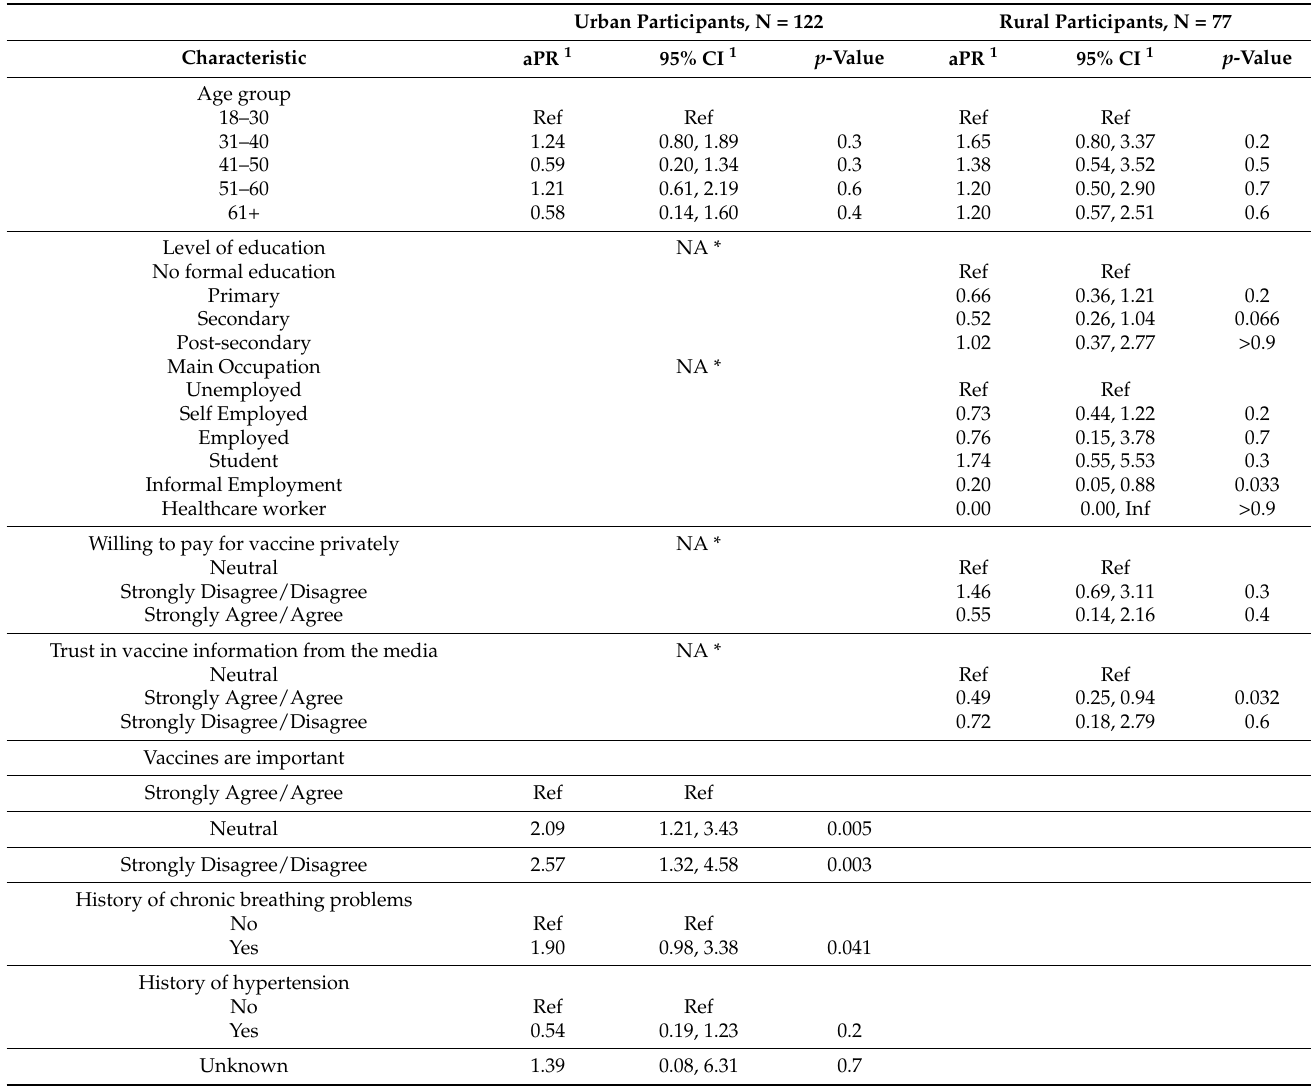
Table 5. Factors associated with COVID-19 vaccine refusal among study